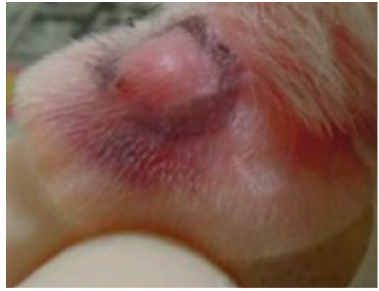
Figure 8. P . acnes -induced ear edema in Wistar rats.